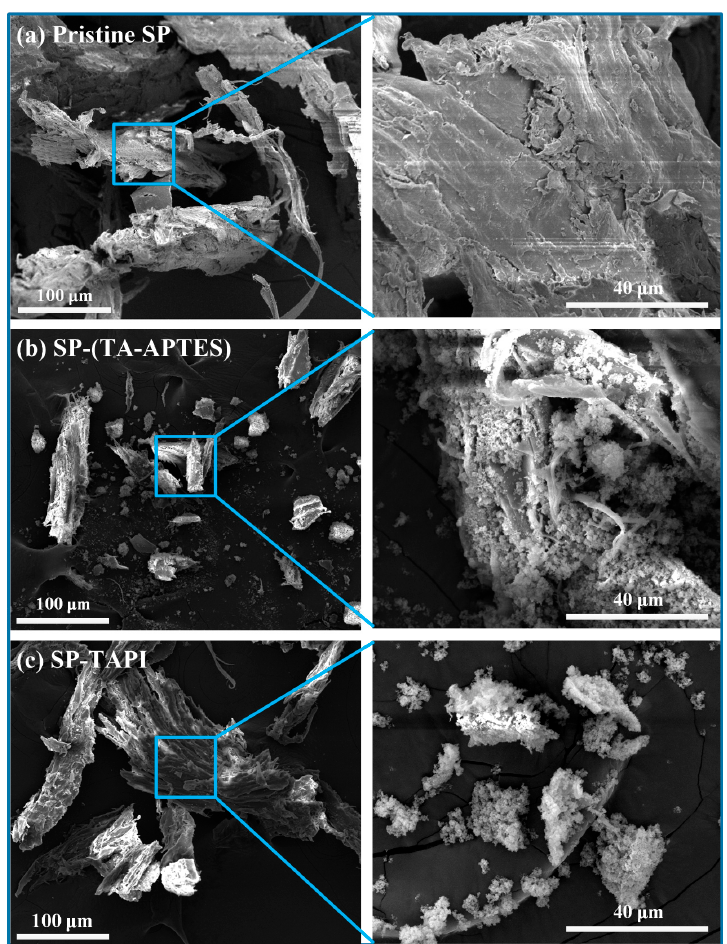
Figure 2. SEM images of ( a ) pristine SP, ( b ) SP-(TA-APTES), and ( c ) SP-TAPI composites, respectively.